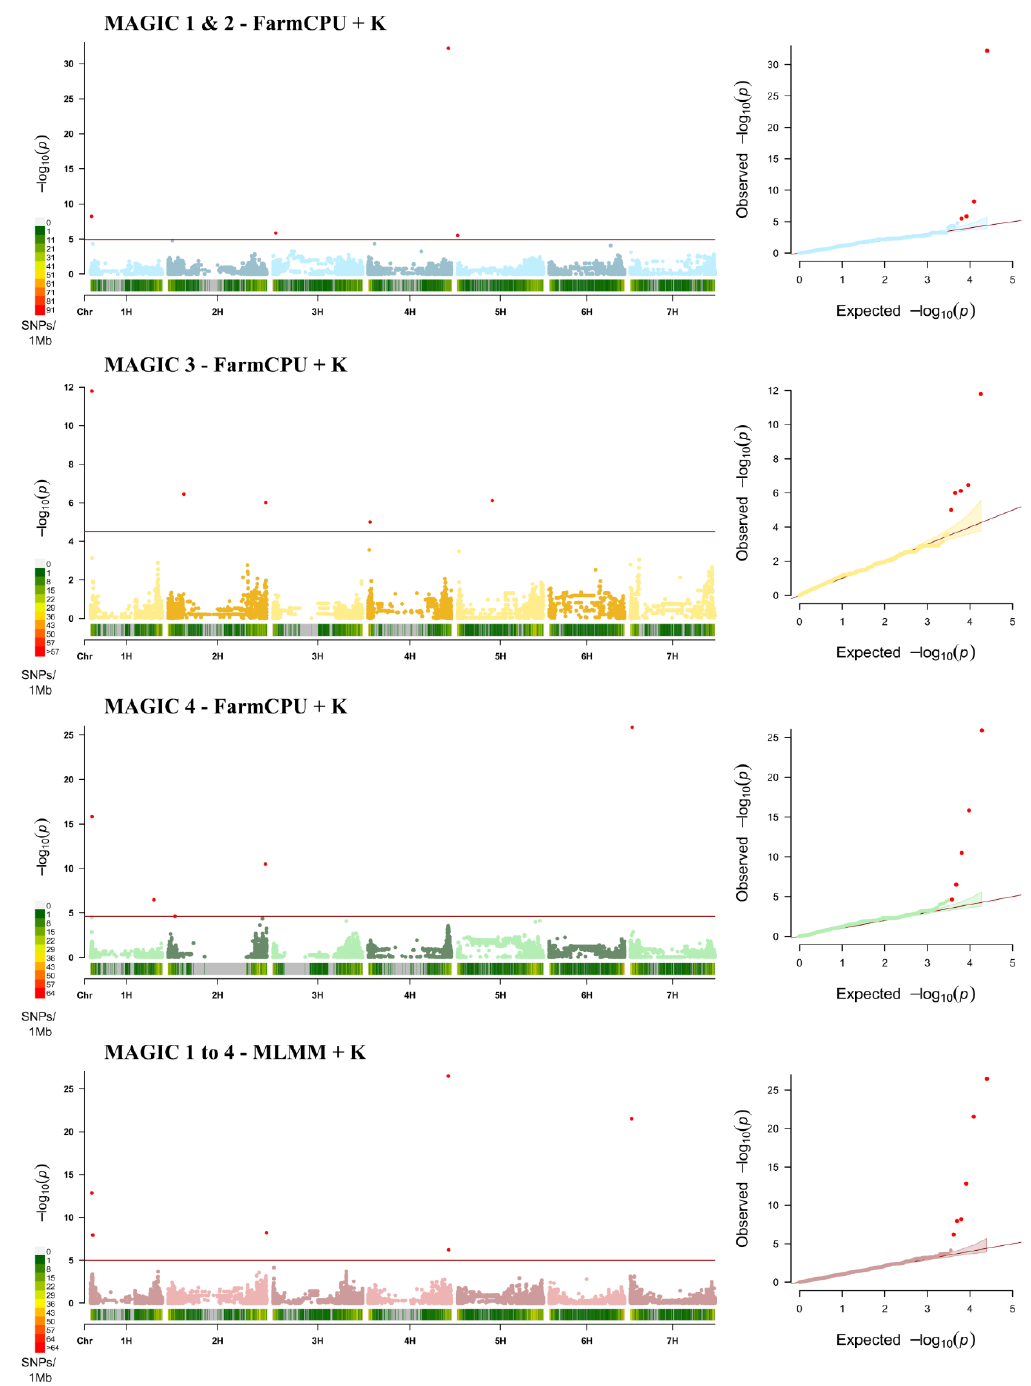
Figure 3. Manhattan plots of the best model and respective quantile–quantile (QQ) plots for each spring barley MAGIC population. The x -axis shows the seven barley chromosomes with physical positions, the y -axis displays the − log10 ( p )-values. The red horizontal line represents the Bonferroni adjusted significance threshold –log10 ( p ) with values of 4.93 (MAGIC 1 + 2), 5.1 (MAGIC 3), 4.6 (MAGIC 4), and 4.99 (MAGIC 1 to 4), corresponding to an experiment wise error rate of